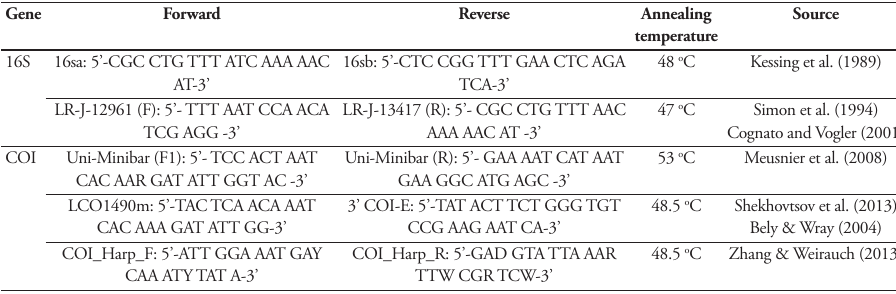
Table 2. Primers used for PCR amplification and Sanger sequencing.